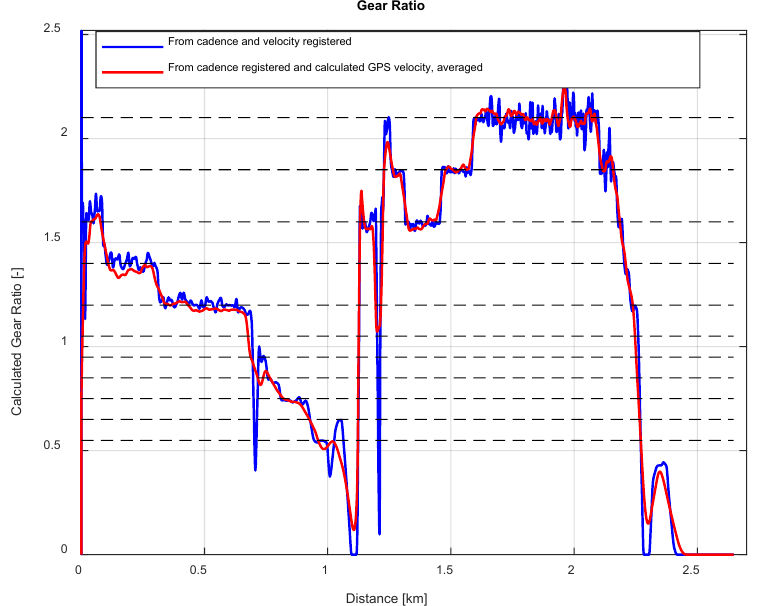
Figure 6. Gear ratios calculated from cadence and speed signals.